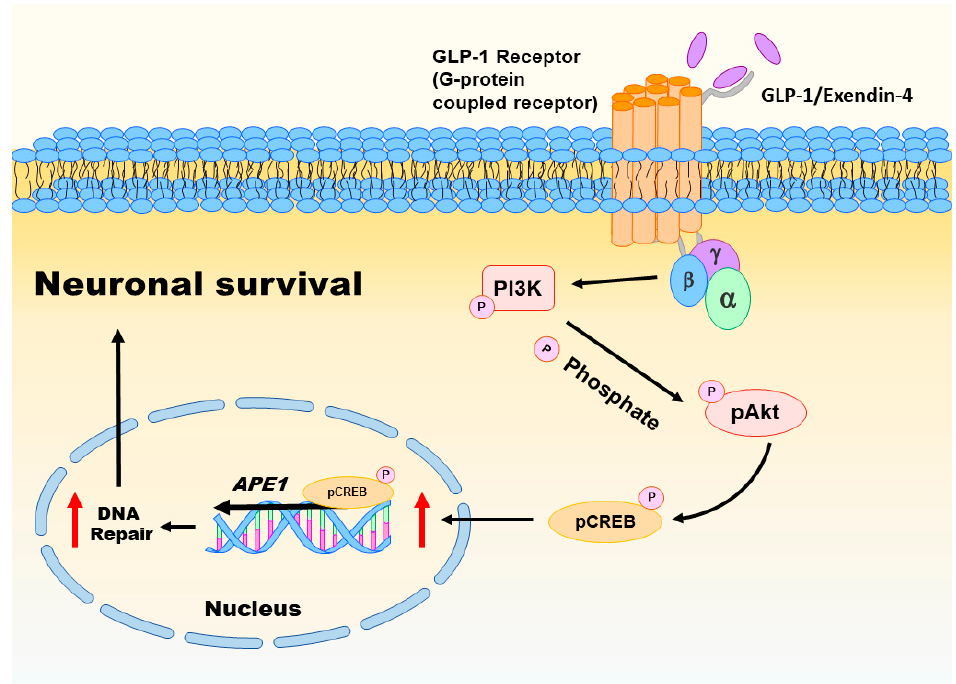
Figure 2. This schematic diagram shows the active GLP-1R induced mechanisms that enhance DNA repair efficiency and neuronal survival. The stimulation of GLP-1R enhances APE1 expression and increases DNA repair via the PI3K-AKT-mediated signaling pathway. The greater DNA repair efficiency provides better genomic integrity and greater neuronal viability. Red arrow: increased activity.